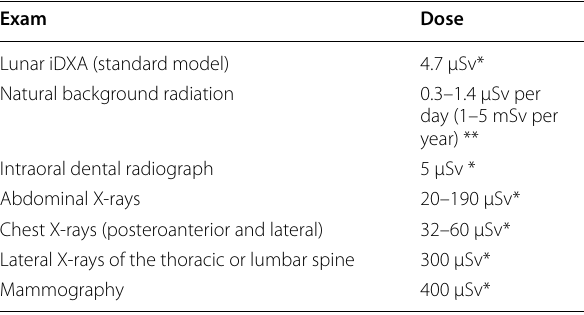
Table 3 Effective radiation doses (μSv) from ambient exposure, DXA scanning, and radiographic tests [96,